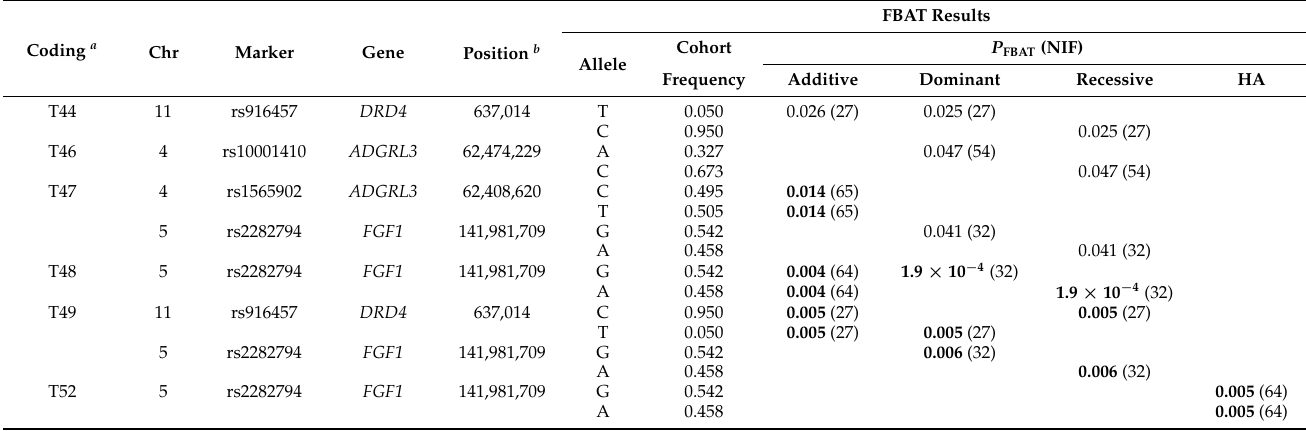
Table 2. Results of the FBAT on ADHD endophenotypes in 113 nuclear families from an African-descent community.